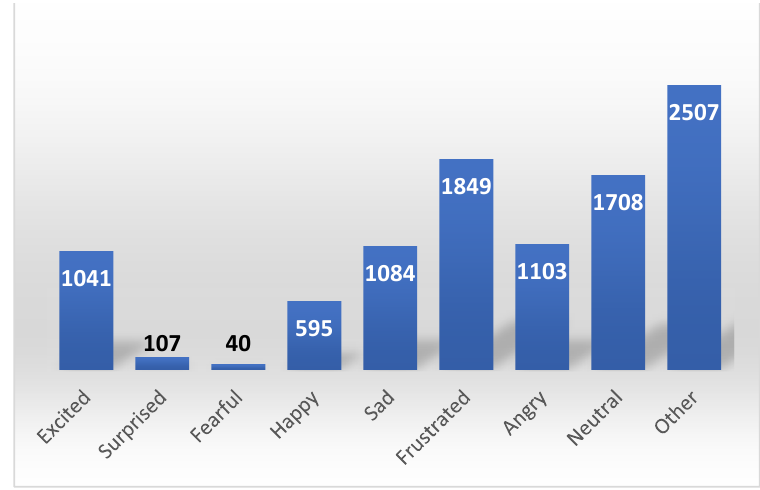
Figure 1. Distribution of sample number for 9 emotions.